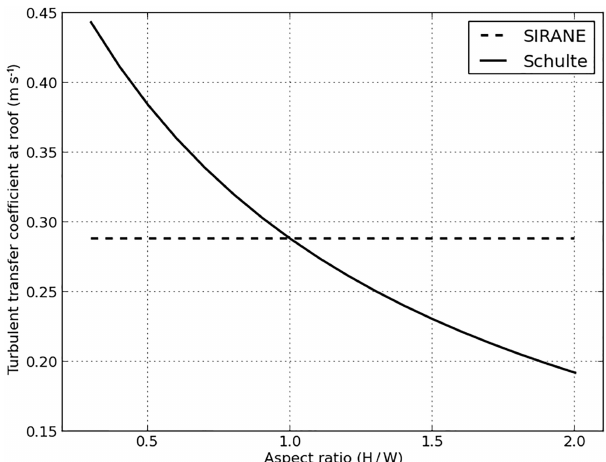
Figure 1. Comparison of the turbulent transfer coefficients of the SIRANE formulation (dotted line) and the formulation of Schulte et al. (2015) (solid